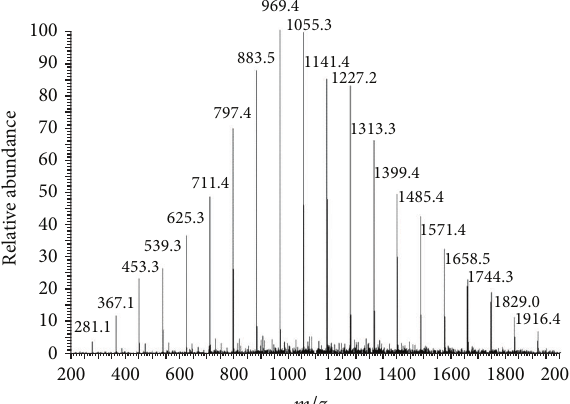
Figure 5: ESI-MS spectrum (positive-ion mode) of the oligomers obtained via degradation of O-PHB in the presence of potassium acetate.